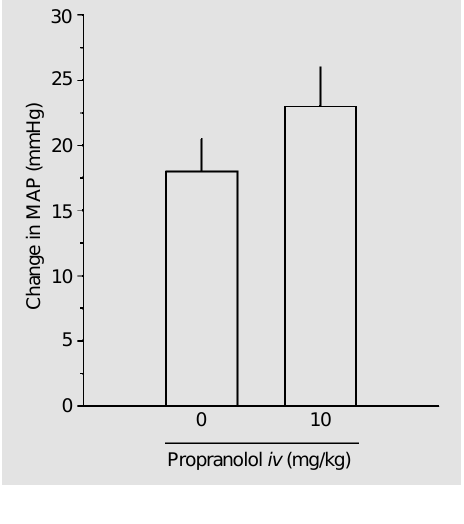
Figure 4. Effect of intravenous injection of propranolol on the pressor response to icv losartan (90 µg). N = 8 for each group. MAP = mean arterial pressure. There was no statistical effect of propranolol (Student-New- man-Keuls test).